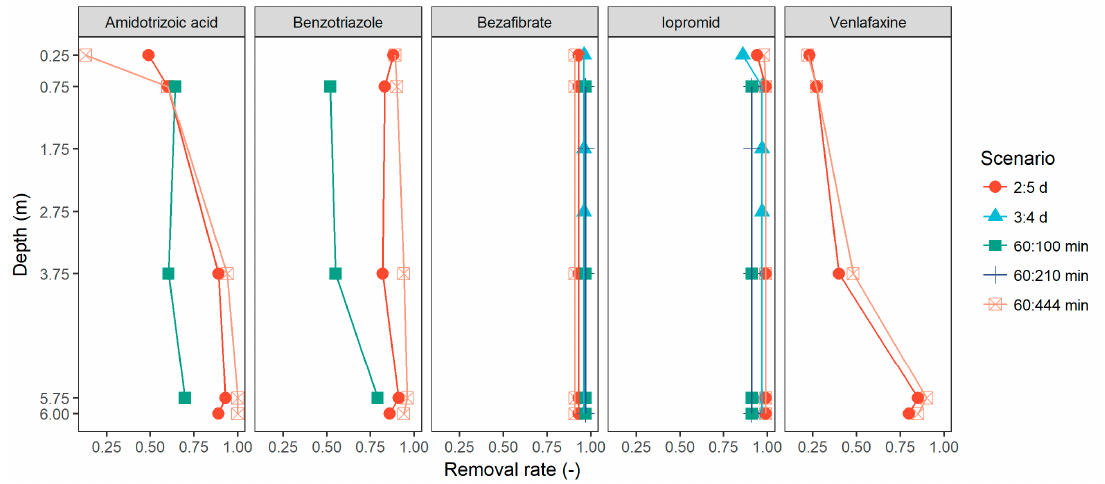
Figure 5. Depth profiles of removal rates (-) for amidotrizoic acid, benzotriazole, bezafibrate, iopromide and venlafaxine along 6 m column for five different scenarios. Values below DL were regarded with DL/2.